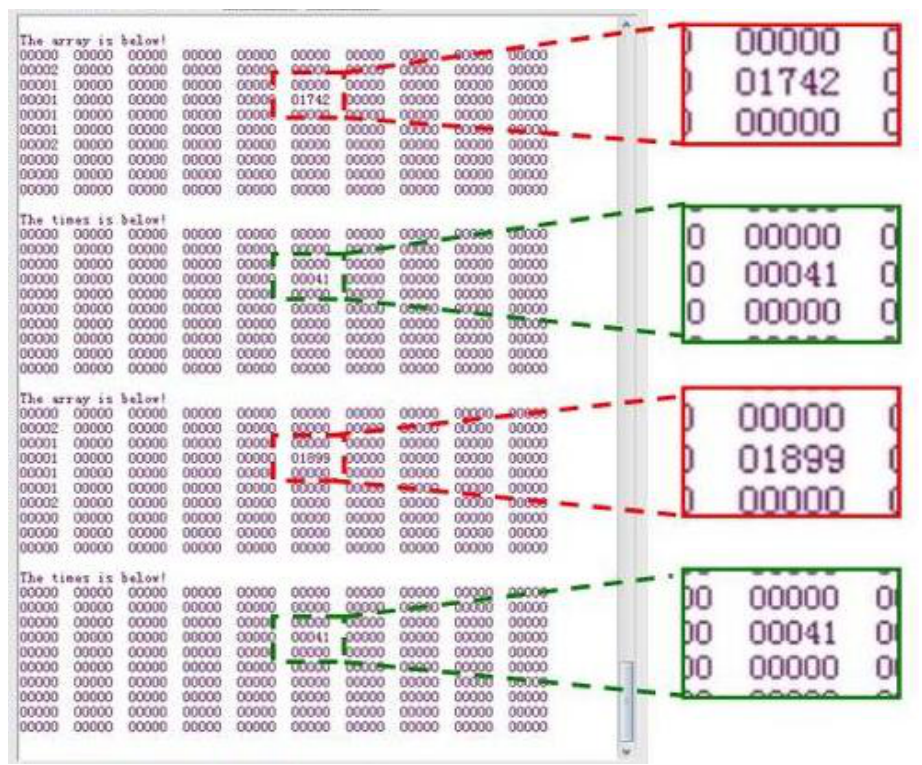
Figure 21. Screenshot of the wireless transceiver software.